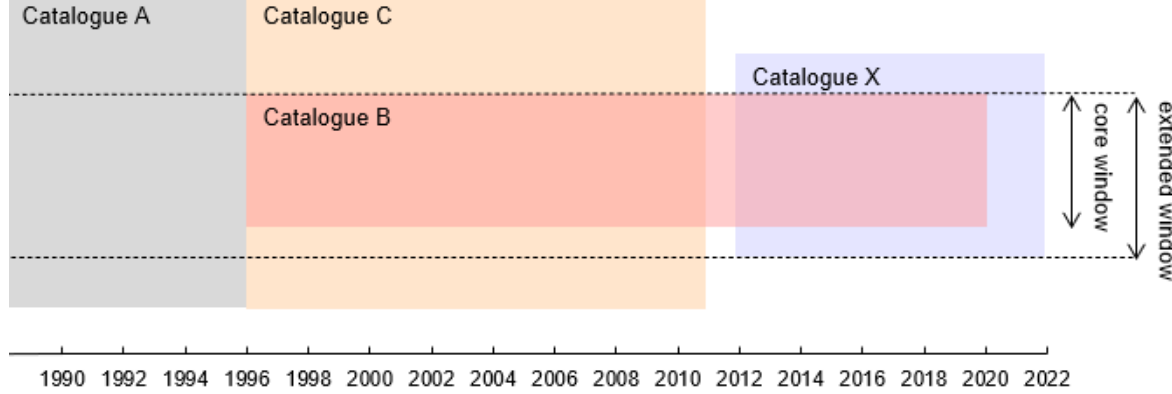
Figure 1. Schematic diagram of the coverage and overlaps of the source catalogues used in the study. Microseismic events caused by quarry blasts and explosions had been identified and excluded from the datasets during the preparation of the catalogues prior to this study. It is observed that the events in the Romanian area of the study show unusual magnitude–frequency patterns. This suggests an inhomogeneity of the merger of the primary sources underlying the Romanian part of catalogue C. Therefore, the affected area is excluded from the ETAS parameter fitting due to concerns of data quality. The boundary of the excluded area follows the area source zone boundaries of the SHARE project